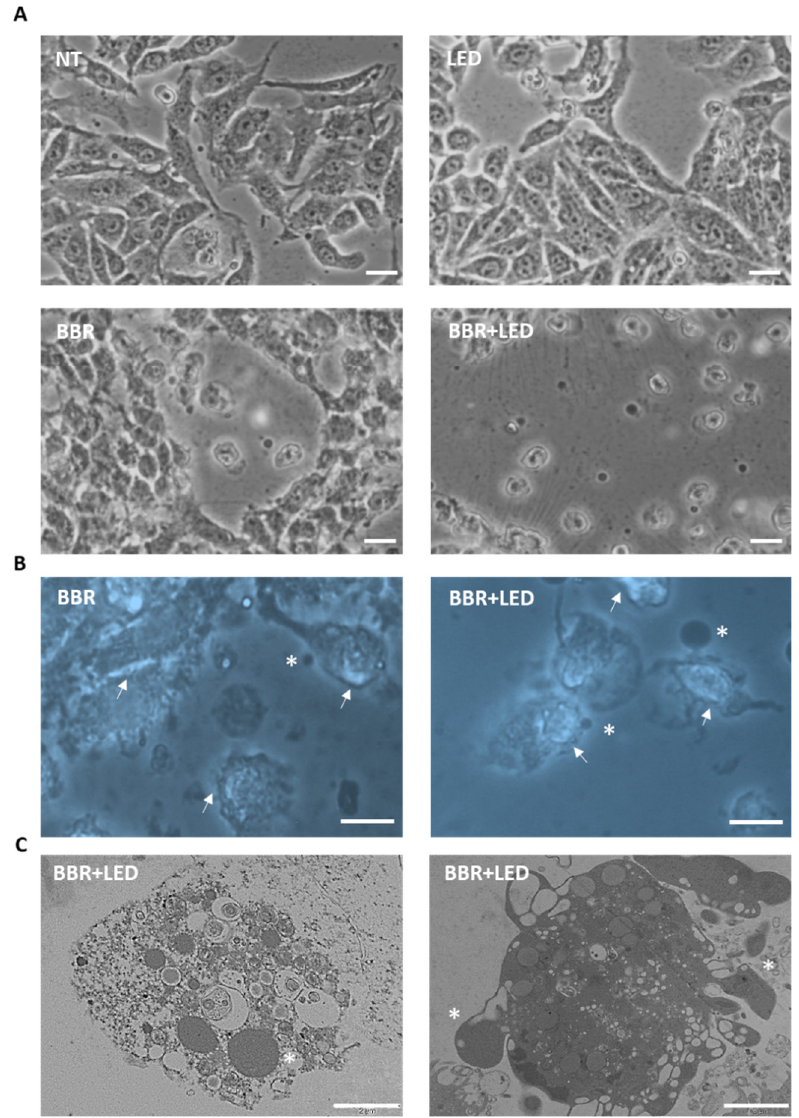
Figure 5. Cytotoxic effect of BBR and PDT. Phase contrast ( A ), fluorescence ( B ) and transmission electron microscopy ( C ) analysis of untreated T98G cells (NT), with only LED stimulation, after BBR administration (200 μ g/mL for 4 h) and with the combined BBR + LED treatment. Cells were analyzed after 24 h p.t. BBR intracellular accumulation (ext. 355 nm) is indicated by arrows ( B ); asterisks indicated apoptotic bodies ( B , C ). Scale bars = 10 μ m ( A , B ) and 2 μ m ( C ).